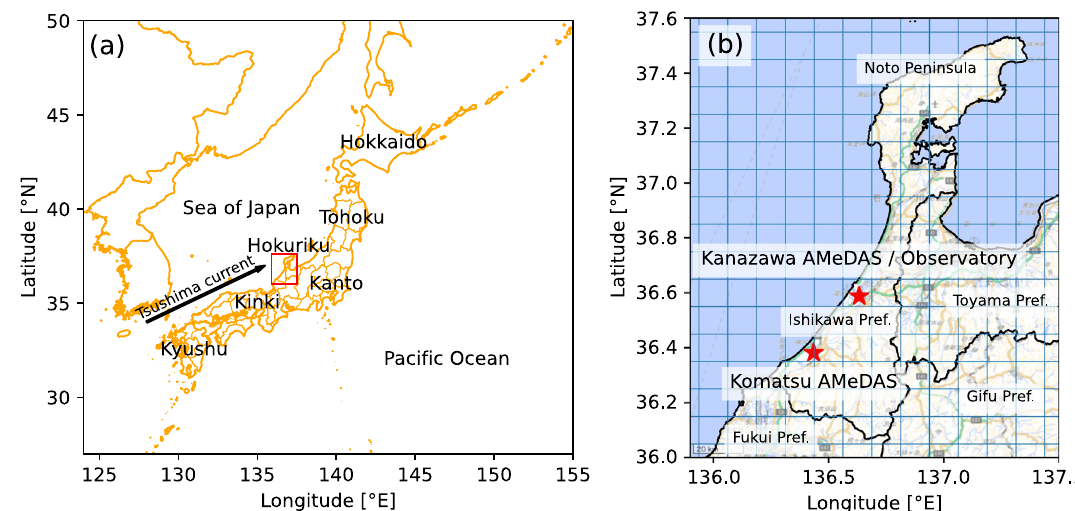
Fig. 1 Maps around Japan and Ishikawa Prefecture. a A map of Japan with region names. The red rectangle shows the area shown in the right panel. b A map of Ishikawa Prefecture. Red stars show the Kanazawa and Komatsu AMeDAS stations. The Kanazawa local meteorological observatory is located at the same place as the Kanazawa AMeDAS station. The blue mesh indicates the MSM grid. Black lines on the maps are prefectural